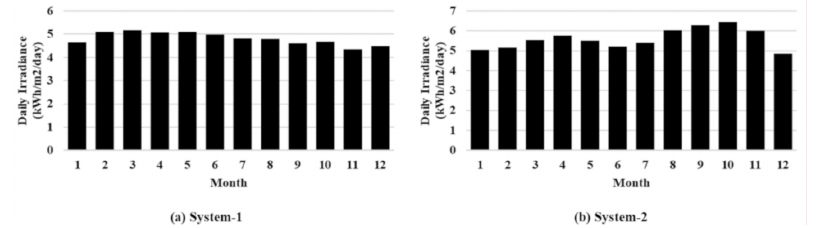
Figure 11. Daily solar irradiance profile. System-1 had peak daily irradiance in March, and System-2 had peak daily irradiance in